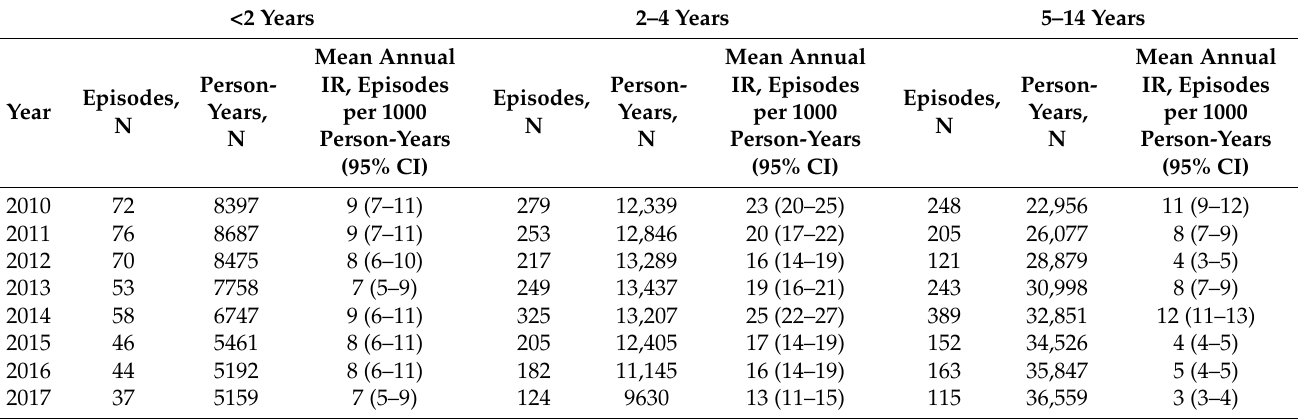
Table 5. Annual incidence estimates for non-invasive pneumonia stratified by